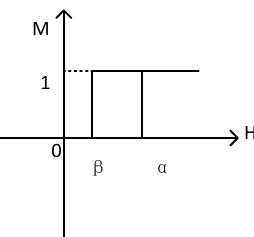
Figure 3. The hysteresis operator of the probability